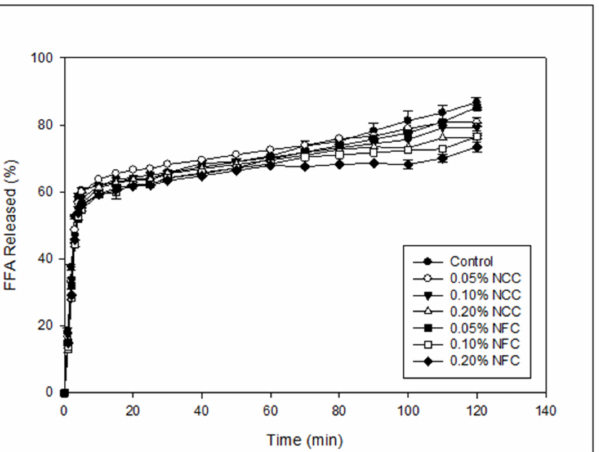
Figure 7. Influence of nanocellulose type and concentration on the release of free fatty acids (FFA)